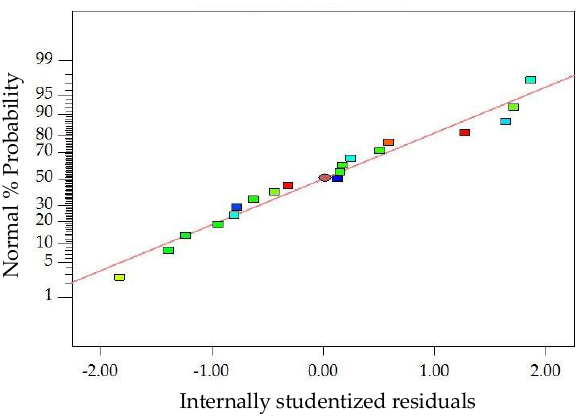
Figure 14. Diagnostics of statistical model: normal plot of residuals for VFA .